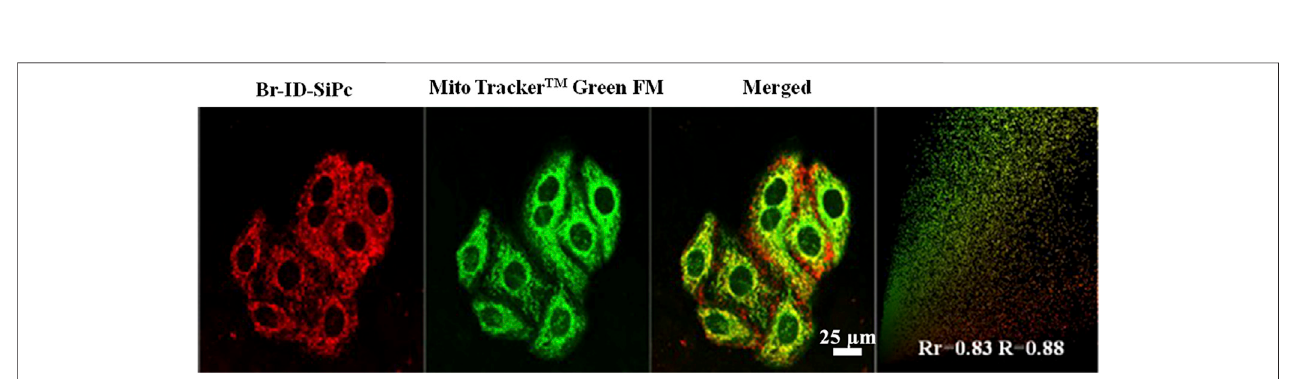
FIGURE 4 | Confocal microscopy fl uorescence images of Br-ID-SiPc (red, λ ex = 860 nm, λ em = 650 – 750 nm) and MitoTracker ™ Green FM (green, λ ex = 488 nm, – 550 nm) in HO-8910 λ em = 500